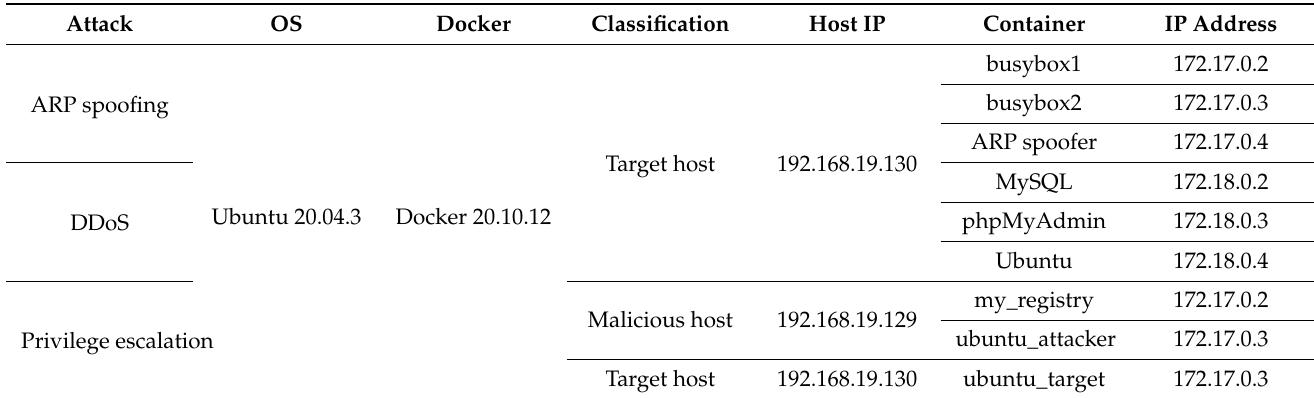
Table 5. Summary of Docker network security threats